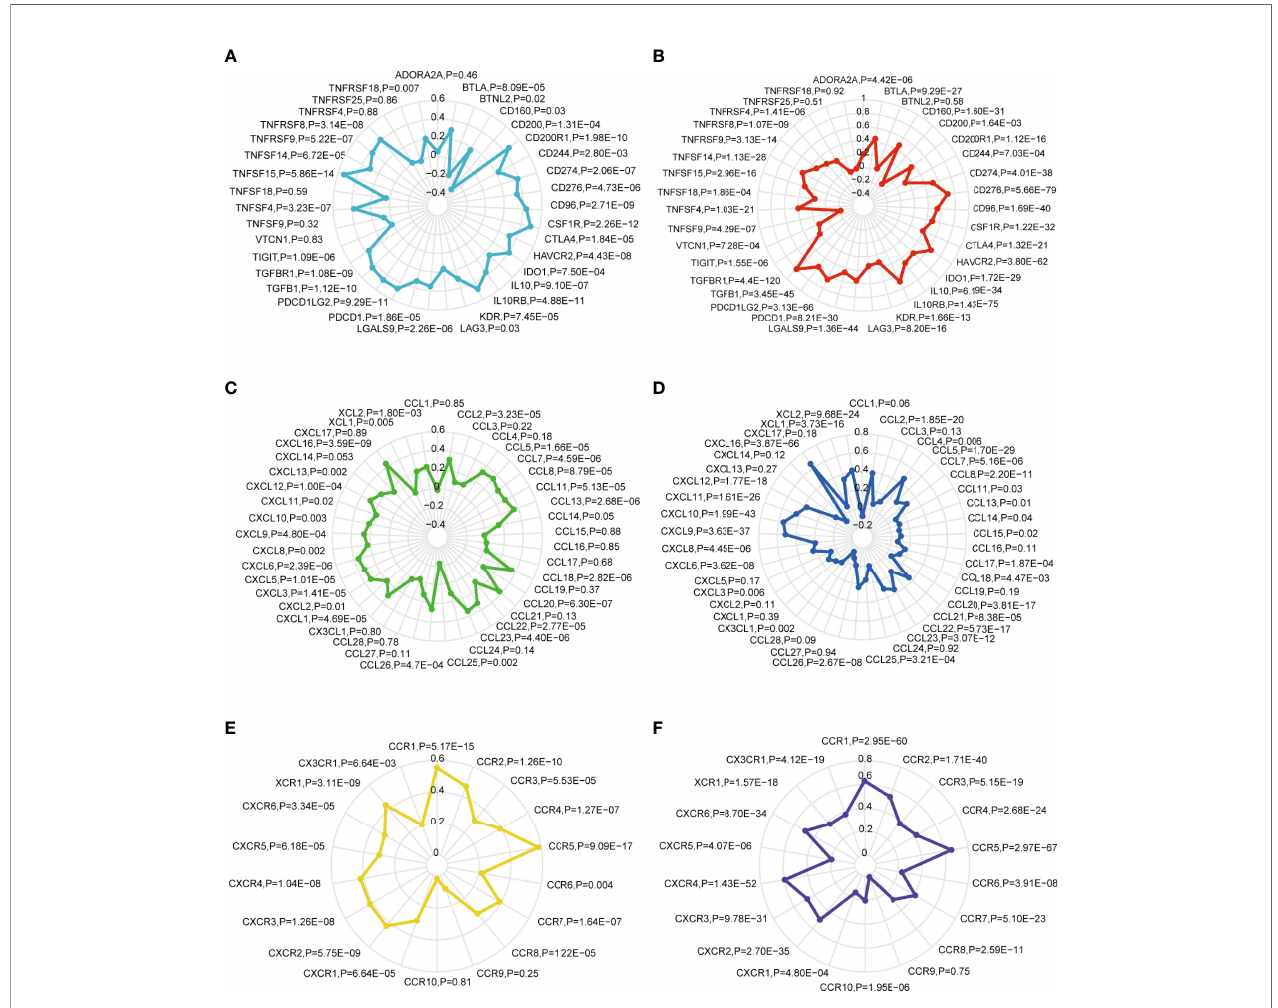
FIGURE 6 | SOAT1 expression was positively correlated with multiple immune checkpoint genes and chemokine/chemokine receptor genes. (A) The Pearson correlation between SOAT1 expression and immune checkpoint gene levels in GBM based on TCGA cohort. (B) Pearson ’ s correlation coef fi cient between SOAT1 expression and immune checkpoint gene levels in LGG based on TCGA cohort. (C) Pearson ’ s correlation coef fi cient between SOAT1 expression and chemokine gene levels in GBM based on the TCGA cohort. (D) Pearson ’ s correlation coef fi cient between SOAT1 expression and chemokine gene levels in LGG based on the TCGA cohort. (E) Pearson ’ s correlation coef fi cient between SOAT1 expression and chemokine receptor gene levels in GBM based on the TCGA cohort. (F) Pearson ’ s correlation coef fi cient between SOAT1 expression and chemokine receptor gene levels in LGG based on the TCGA cohort. SOAT1 , sterol O-acyltransferase 1 ; GBM, glioblastoma; TCGA, The Cancer Genome Atlas; LGG, lower grade